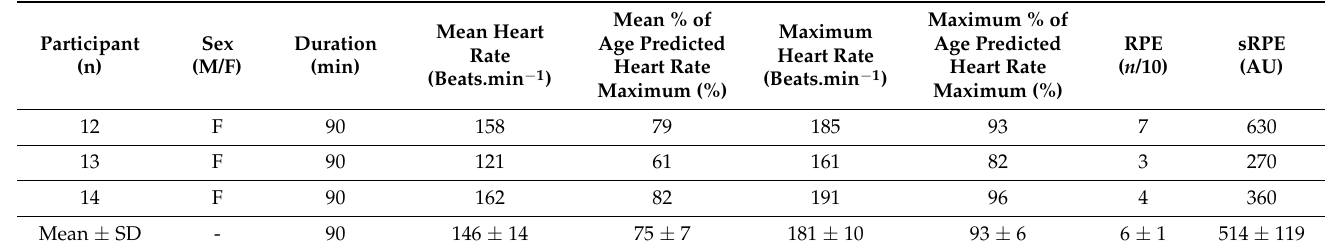
Figure 2 conveys the body mass loss/gain of players throughout the training session. Eleven players lost body mass throughout the session, while three players gained mass. The mean body mass loss/gain was −0.91 ± 0.95 kg. This equated to a mean body mass loss/gain percentage of −1.22 ± 1.22%.